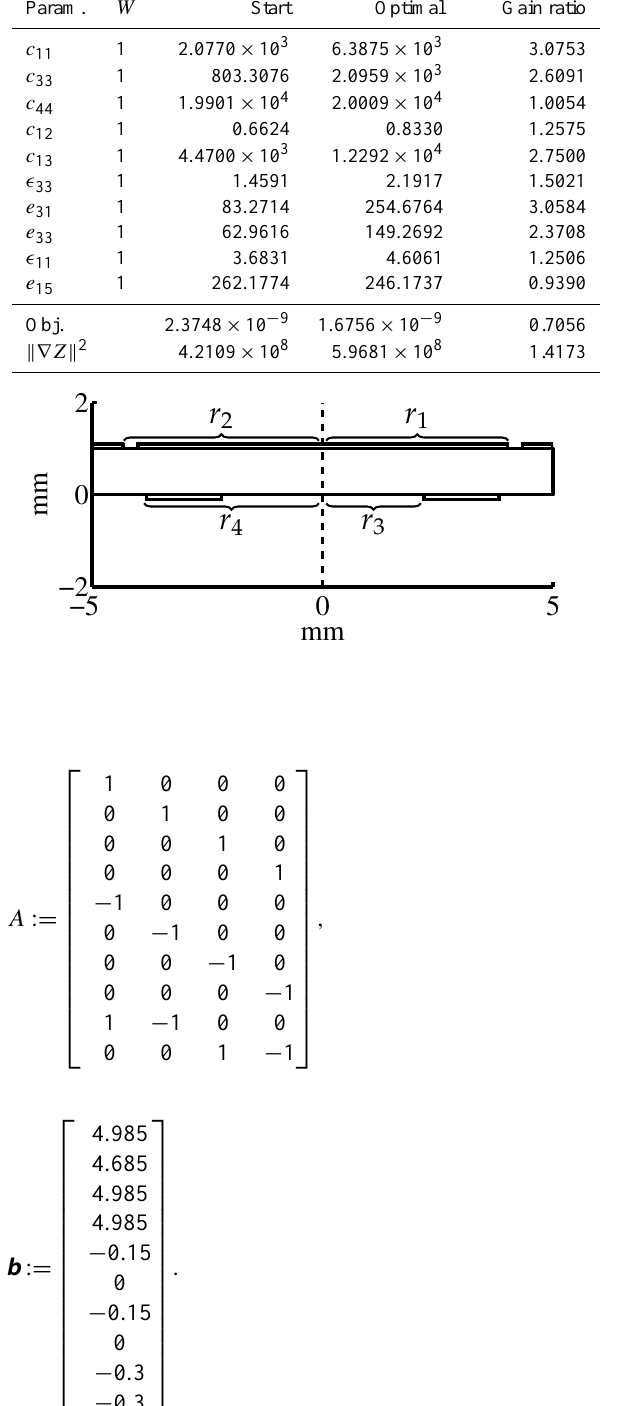
Table 1. Uniform weights: improvement of sensitivity of impedance w.r.t material parameters using W = diag(1 ,..., 1). The sensitivity has increased for all the parameters with exception of e 15 . These are the best component-wise results we have computed so far. Objective function values are shown unscaled. Figure shows resulting geometry utilising uniform weight matrix in millimetres; param.